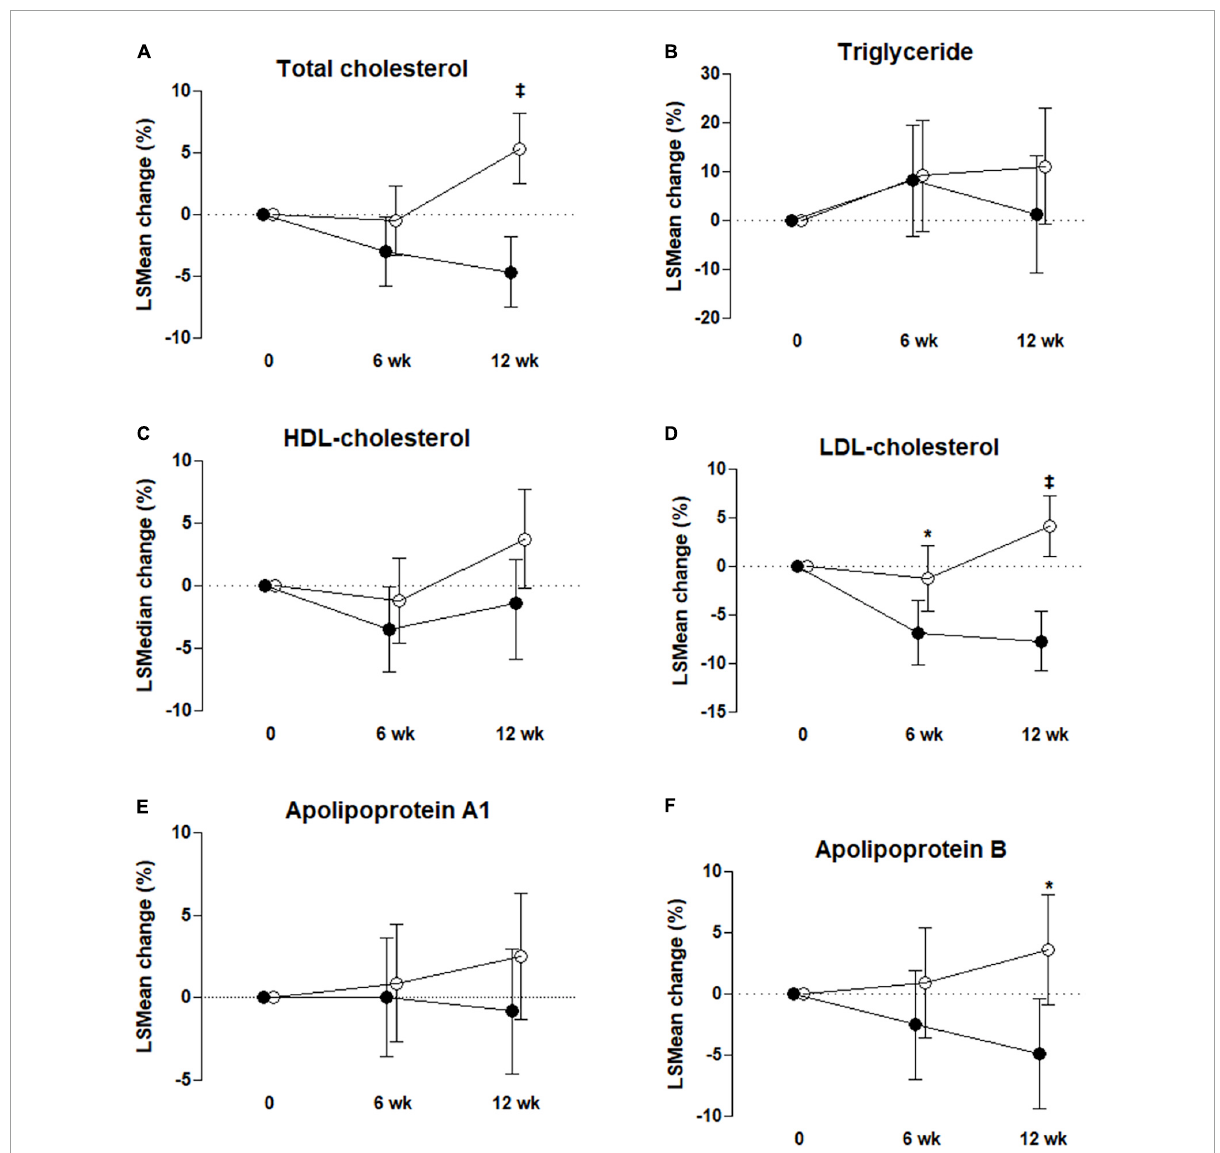
FIGURE2 Percentage change from baseline to 6 and 12 weeks for total cholesterol (A) , triglyceride (B) , high-density lipoprotein (HDL)-cholesterol (C) , low-density lipoprotein (LDL)-cholesterol (D) , apolipoprotein A1 (E) , and apolipoprotein B (F) in the control group, ◦ , and UME group, • . Values are mean ± SD except for triglyceride and HDL-cholesterol (median with IQR). * P < 0.05, ‡ P < 0.001, P -value by ANCOVA or rank ANCOVA with adjustment for each baseline value and baseline dietary fat intake % as covariates; intent-to-treat analysis.